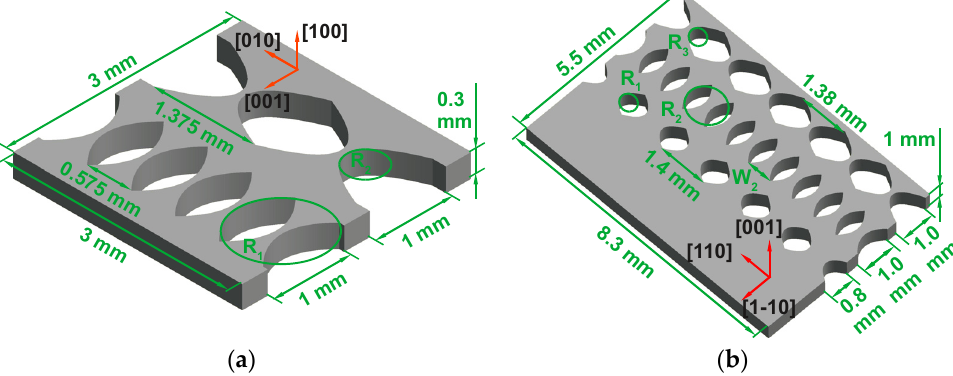
Figure 7. Schematic of the 1D lenses used in the experiment. ( a ) MUL [18]: R 1 = 0.2 mm, R 2 = 0.5 mm; ( b ) NDT [20]: R 1 = 0.2 mm, R 2 = 0.5 mm, W 2 = 0.75 mm, R 3 = 0.2 mm.